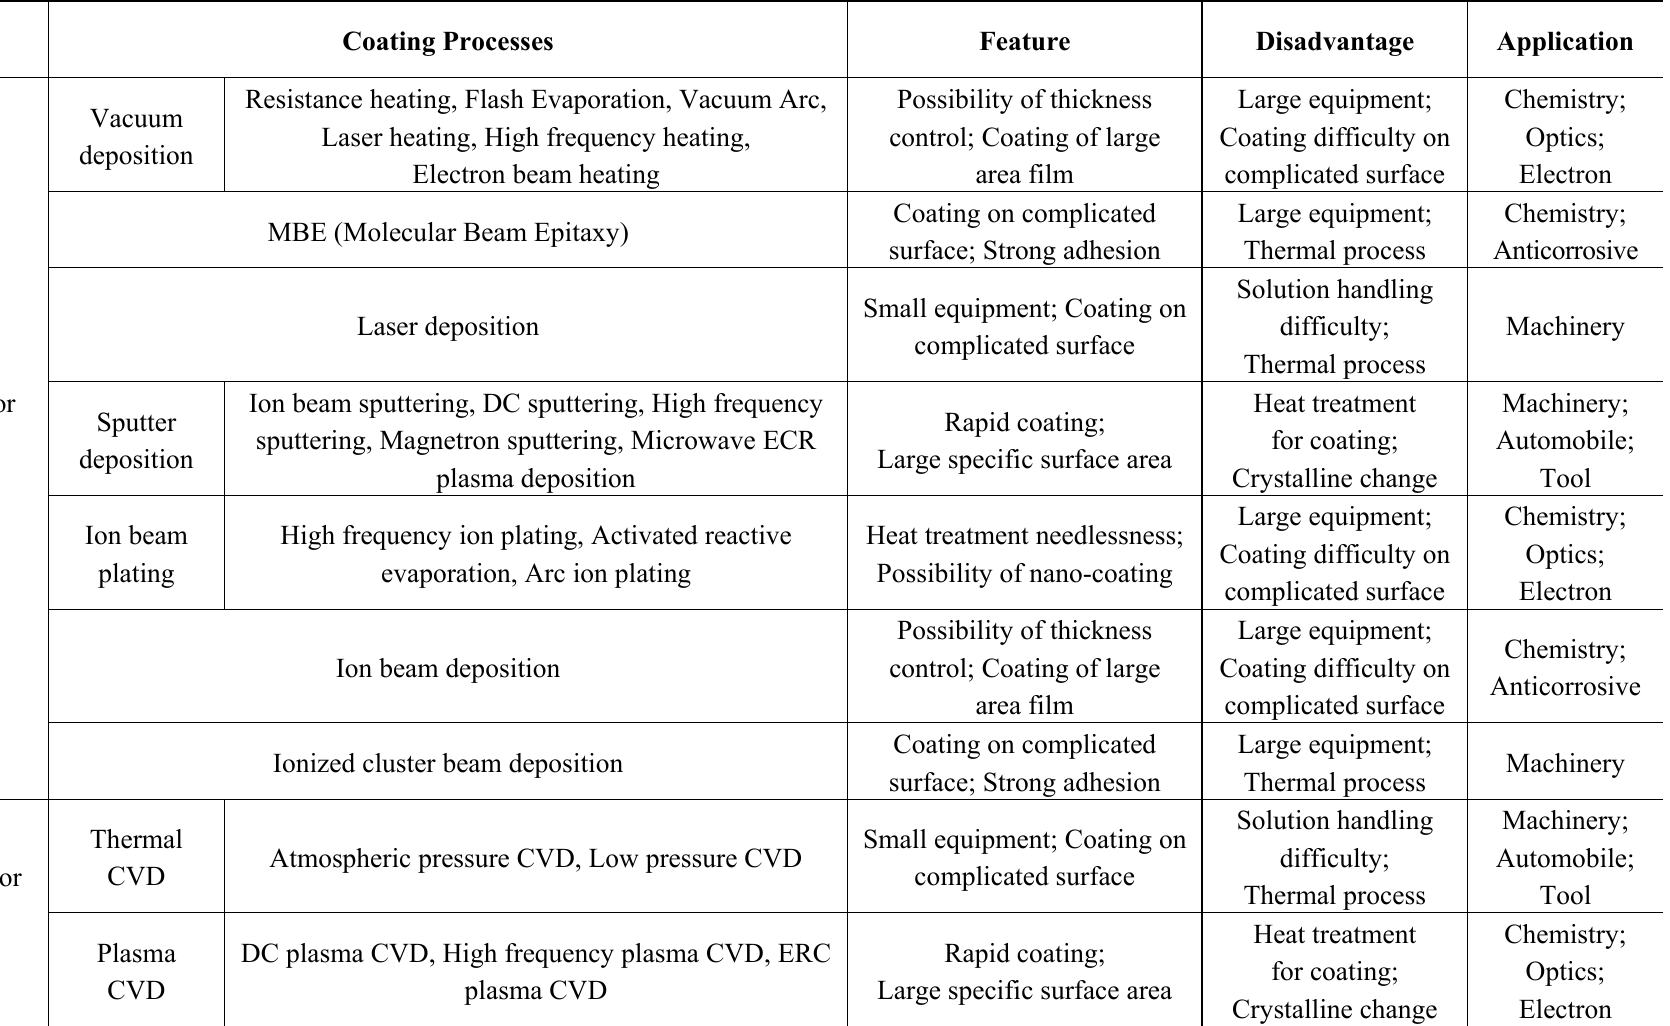
Table 1. Film coating